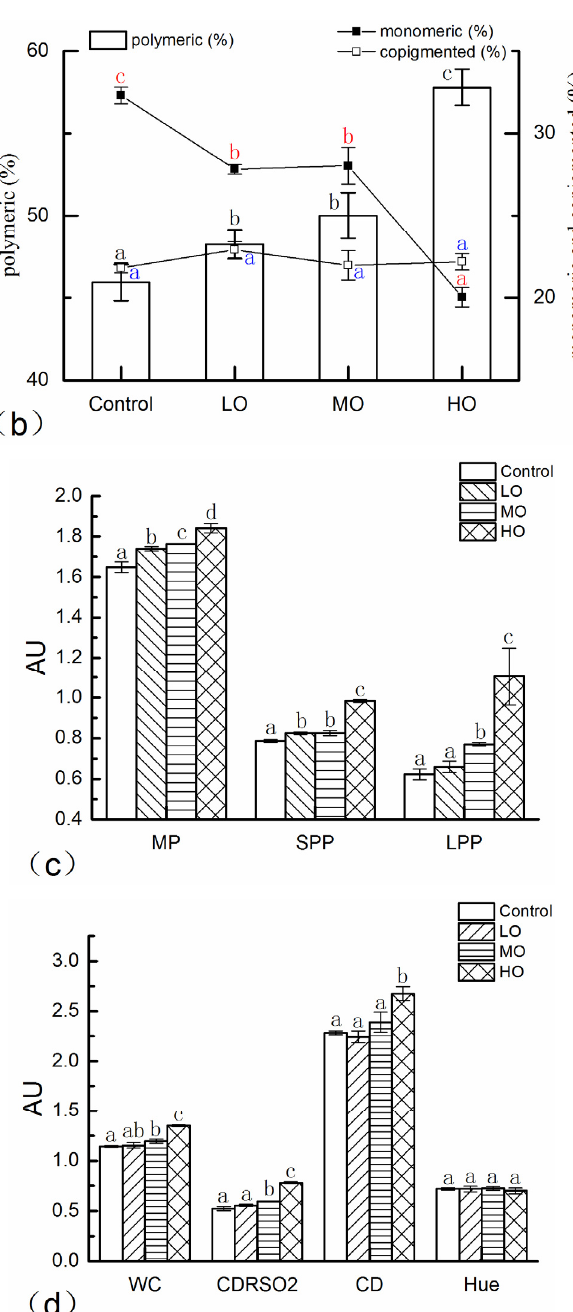
Figure 3. The effects of different oxygen exposure levels on the total phenol and tannin ( a ), monomeric (%), co-pigmented (%) and polymeric (%) ( b ), MP, SPP and LPP ( c ) and WC, CDRSO 2 , CD and Hue ( d ) after oxygenation of five phases. Note: Different letters (a, b, c and d) indicate significant differences at the 0.05 level. In Figure ( b ), letters of black color are for polymeric (%), letters of red color are for monomeric (%) and letters of blue color are for co-pigmented (%). Abbreviations: Control, anaerobic wine (0 mg O 2 /L per time); LO, low-level oxygenation wine (0.5–0.9 mg O 2 /L per time); MO, medium-level oxygenation wine (1–1.9 mg O 2 /L per time); HO, high-level oxygenation wine (3–3.9 mg O 2 /L per time); polymeric, polymeric anthocyanins; monomeric, monomeric anthocyanins; co-pigmented, co-pigmented anthocyanins; MP, monomeric pigments; SPP, small polymeric pigments; LPP, large polymeric pigments; CD, color density. Total anthocyanins in wine comprise monomeric anthocyanins, co-pigmented antho- cyanins and polymeric anthocyanins. Co-pigmentation processes are most characteristic